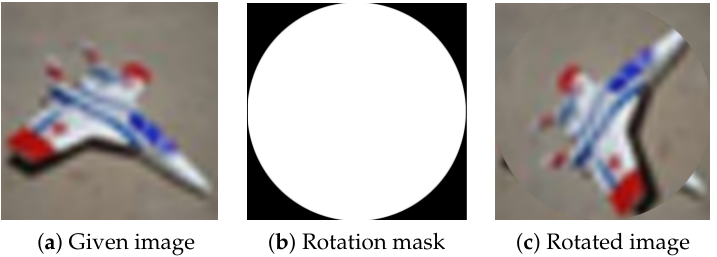
Figure 15. Random local rotation data augmentation technique using the largest possible circular rotation area in the image